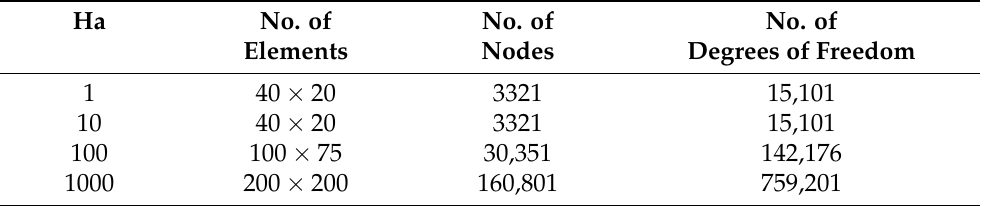
Table 2. Mesh specifications for the two-dimensional buoyancy-driven flow problem.